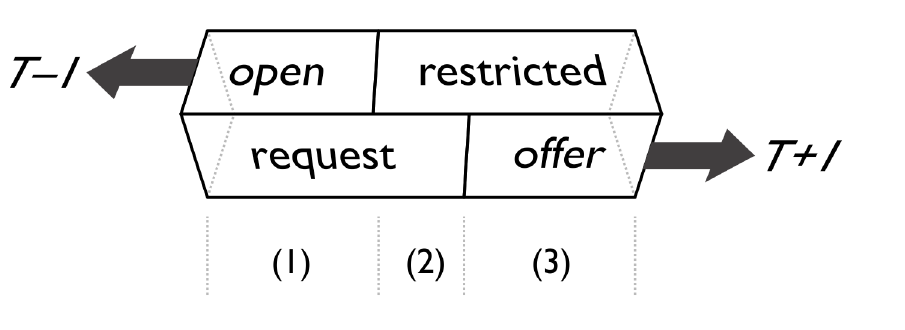
Figure 1: Two dimensions of formats for repair initiation. The distinction between open and restricted type formats is retros- pective: it is about the nature and location of the trouble in prior turn. The distinction between request and offer type formats is prospective: it is about the nature of the response that is relevant in next turn. The two dimensions together define three basic types of formats for repair initiation: (1) open request, (2) restricted request, and (3) restricted